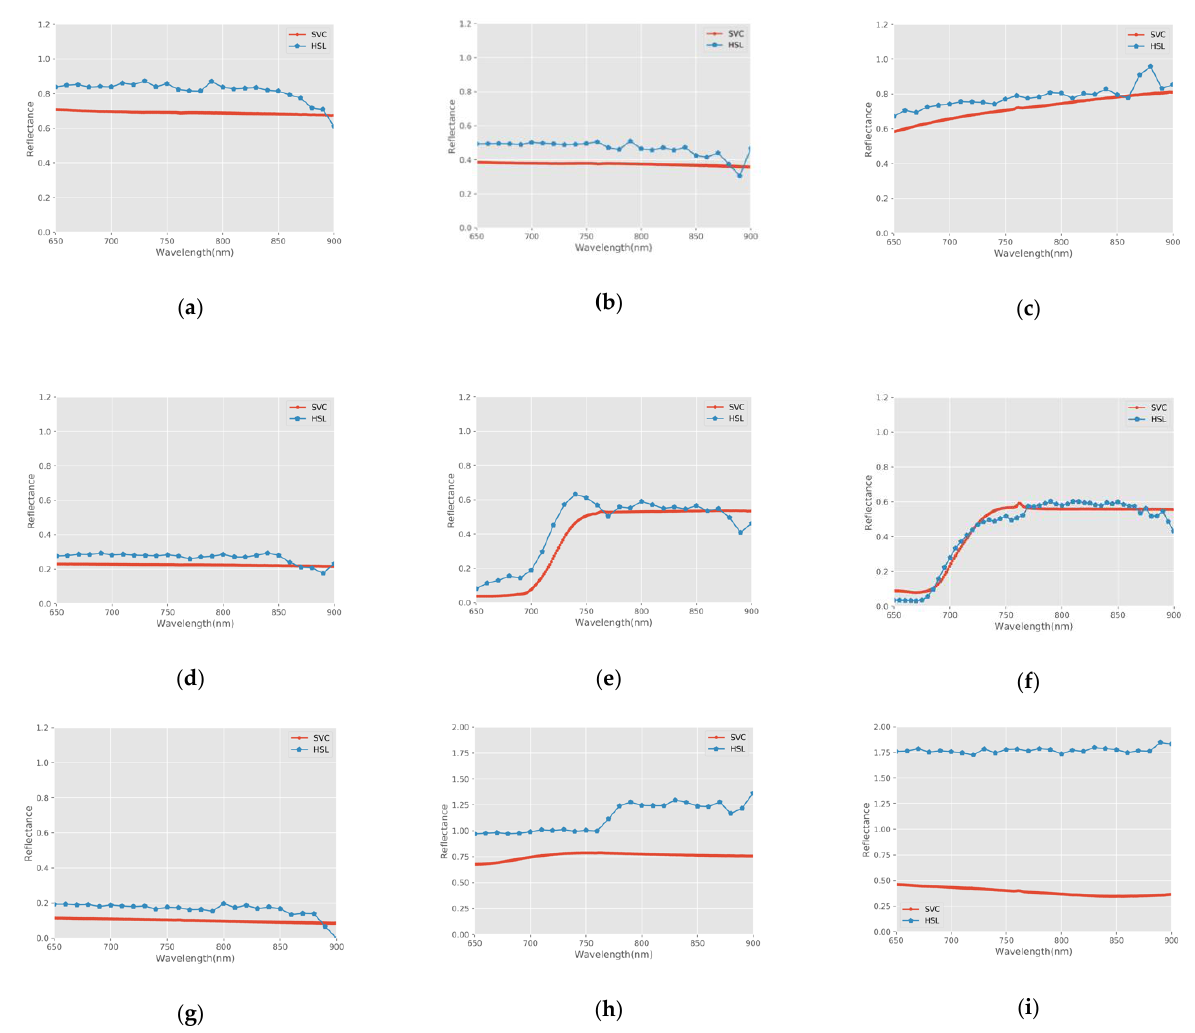
Figure 5. Reflectance comparison of HSL and SVC spectrometer. ( a ) 70% standard reference board; ( b ) 40% standard ref- erence board; ( c ) Wood product; ( d ) Sidewalk brick; ( e ) Ficus elastic; ( f ) Codiaeum variegatum; ( g ) Marble tile; ( h ) Floor tile; ( i ) Car shell